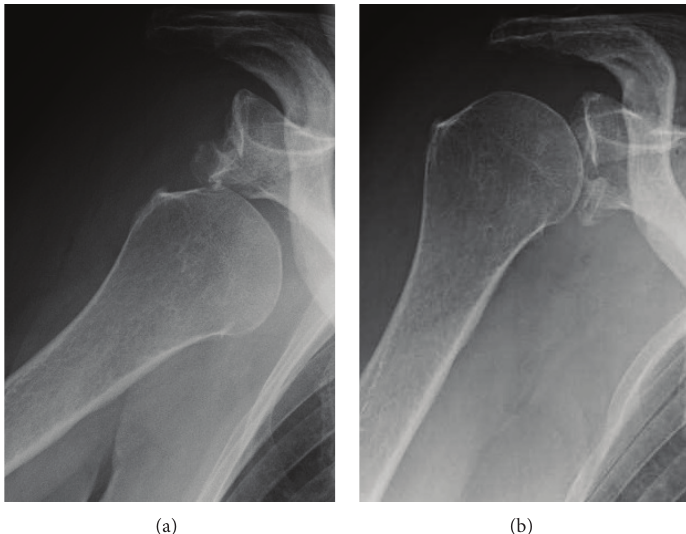
Figure 1: (a) X-ray imaging at the time of injury. (b) X-ray imaging after reduction of anterior shoulder dislocation.